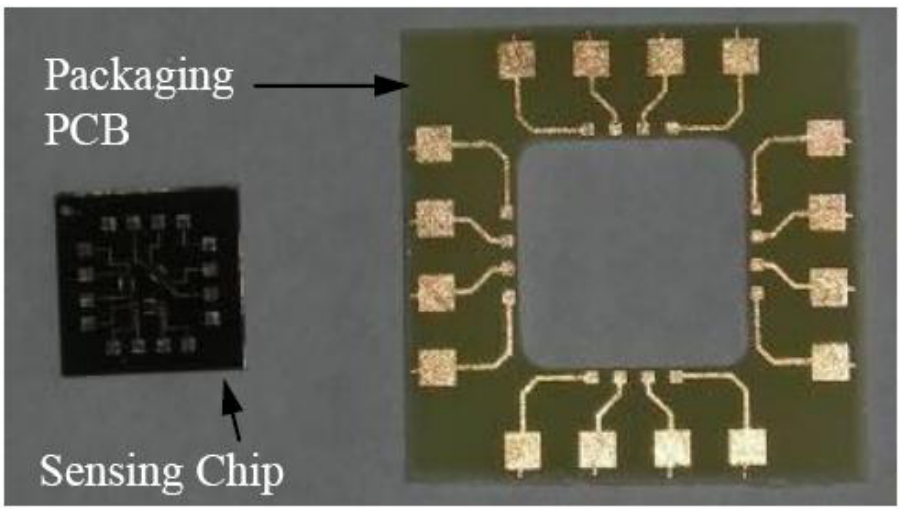
Figure 11. Testing printed circuit board and fabricated MEMS sensing chip before installation on the testing